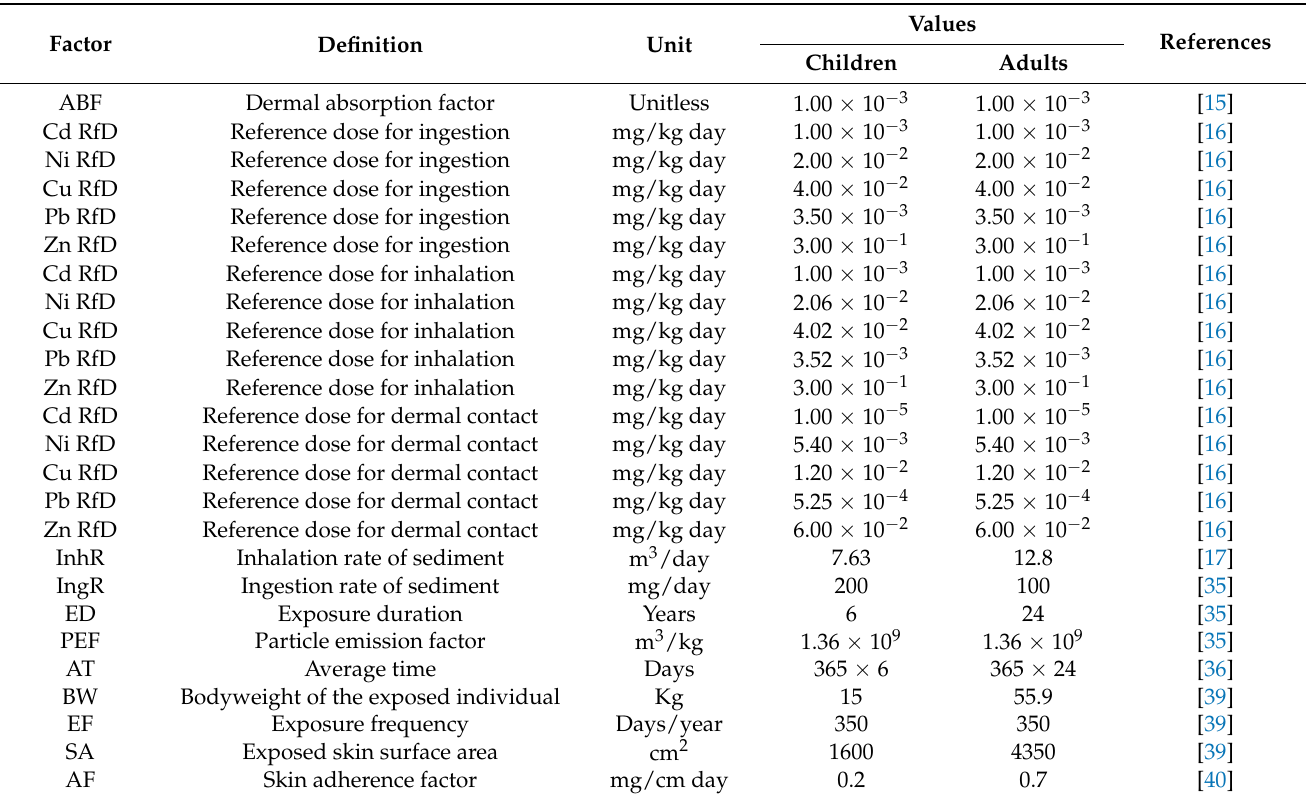
Table 1. Exposure factors, reference values, and their definitions that were used to estimate the intake values and health risks of potentially toxic metals in sediment for the present